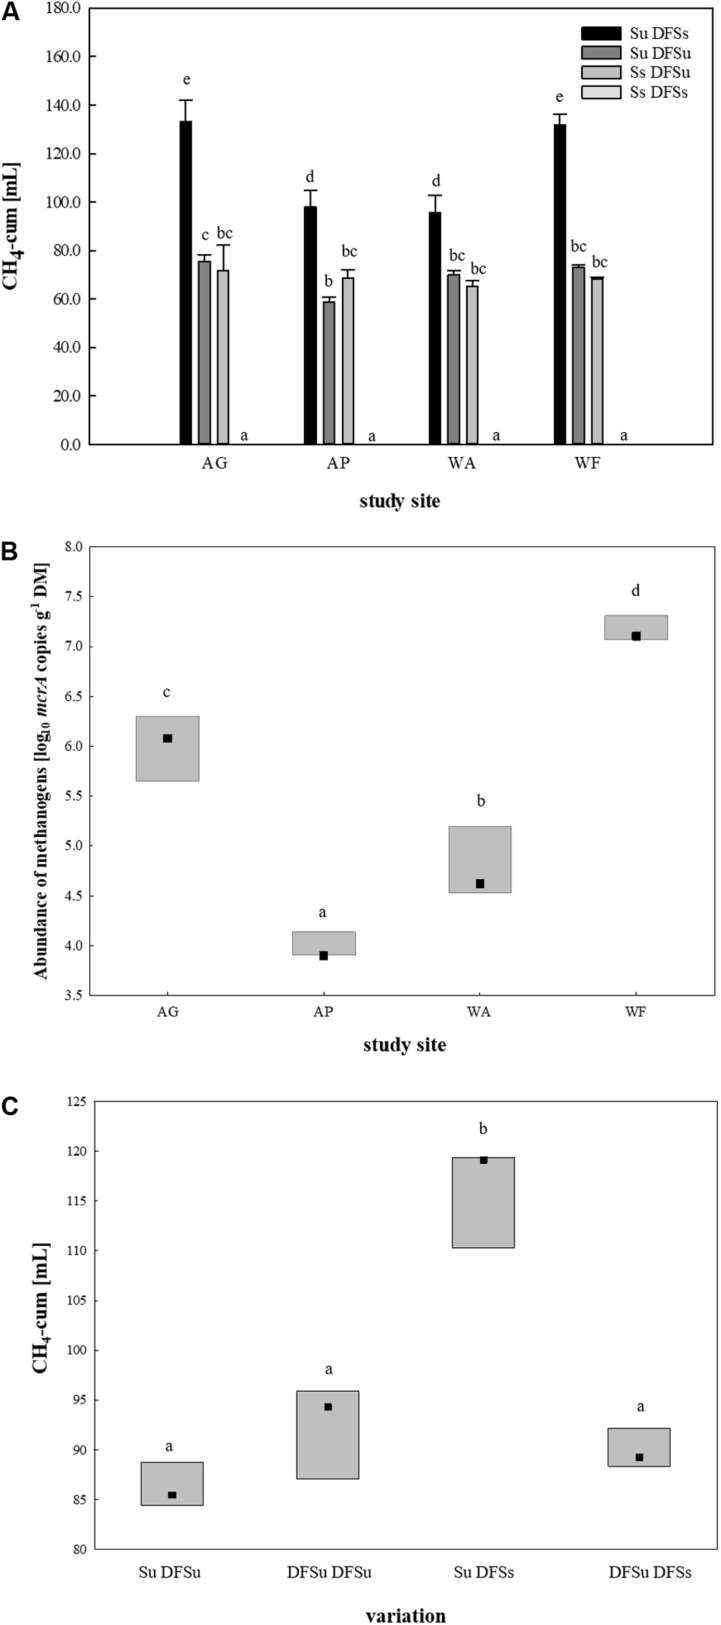
(A) Cumulative CH4 production [mL] in 28 days of anaerobic incubation (undisturbed) in four soils using different inoculations. Results are given as mean (±SD), n = 3. (B)
mcrA targeted qPCR in the four selected soils. Box: median with data range (minimum to maximum), n = 3. Significant differences (p < 0.05) are indicated by different characters. AG, agricultural grassland; AP, agricultural pastureland; WA, waterlogged alluvial soil; WF, waterlogged fen. Su, soil unsterile; Ss, soil sterile; DFSu, diluted fermenter sludge unsterile, DFSs, diluted fermenter sludge sterile; DM, dry matter. (C) Cumulative CH4 production [mL] during 28 days of anaerobic incubation dependent on soil/DFS variation using AG as soil-derived inoculum. Box: median with data range (minimum to maximum), n = 3. Significant differences (p < 0.05) are indicated by different characters. Su, soil unsterile; Ss, soil sterile; DFSu, diluted fermenter sludge unsterile; DFSs, diluted fermenter sludge sterile.